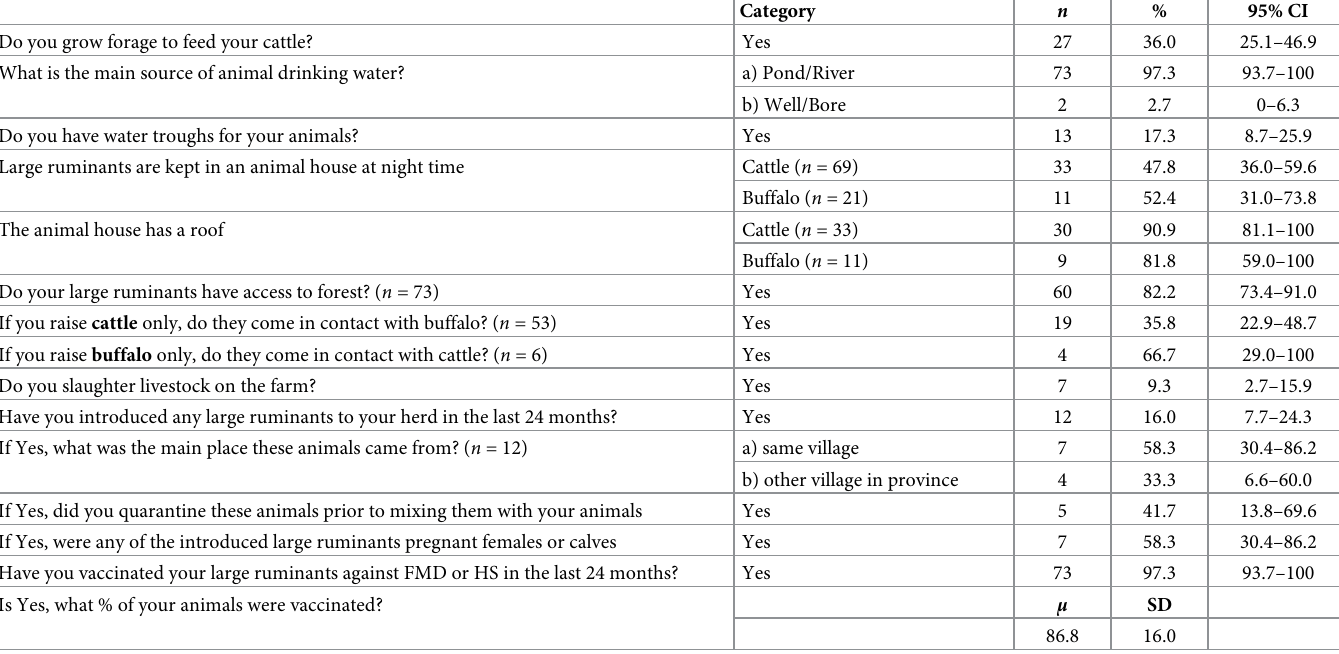
Table 5. Nutritional, biosecurity and management practices in smallholder cattle and buffalo farms in Lao PDR from an epidemiological survey ( n = 75).